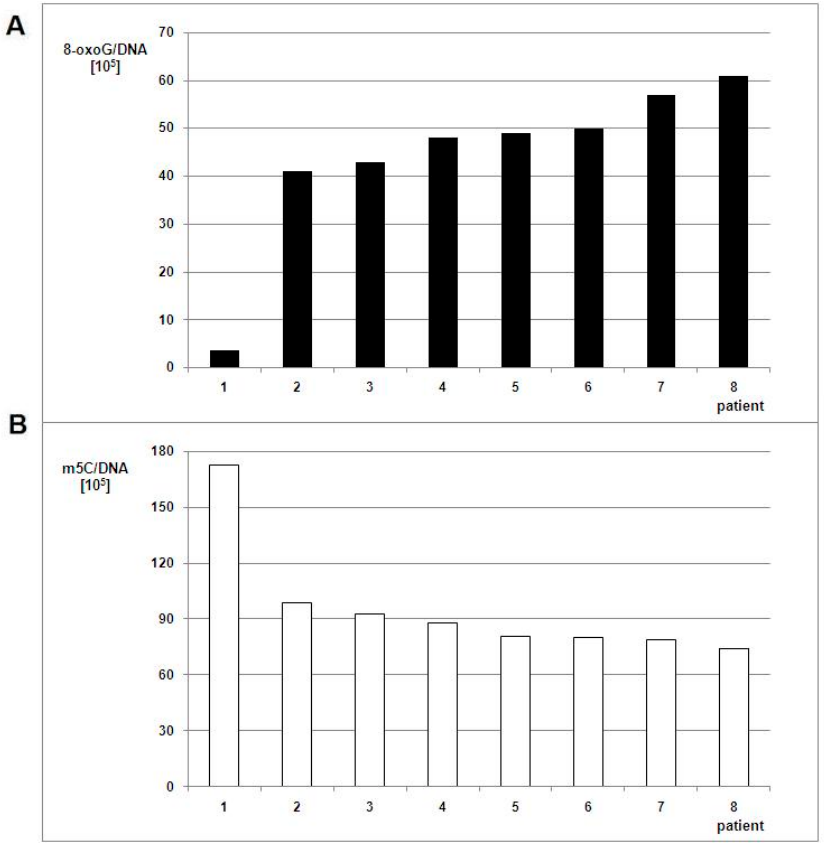
Figure 5. 8-oxo-dG ( A ) and m 5 C ( B ) contents in DNA from the peripheral blood of patients with brain tumors. The white bars correspond to m 5 C contents, the black ones to the number of 8-oxo-dG nucleosides in DNA.